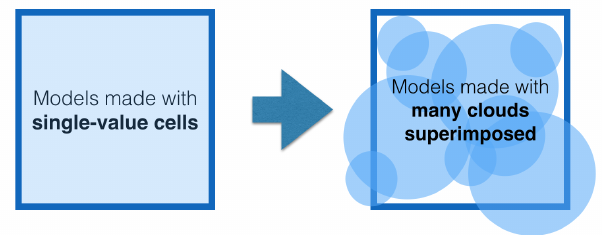
Figure 2. Illustration of the difference between simulating line emission from a cell of constant density, temperature, metallicity etc., and using an ensemble of clouds superimposed to create a more realistic synthetic observation of a patch of the